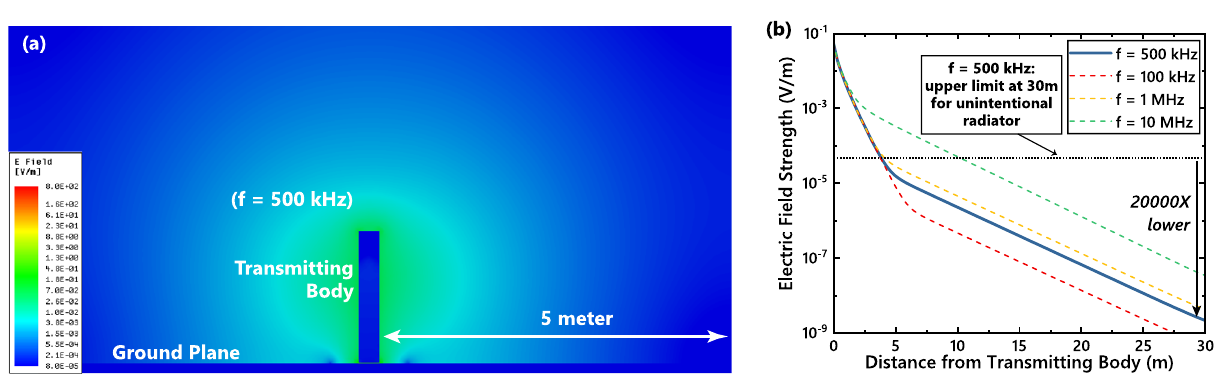
Figure 7. ( a ) Electric field decay from an EQS HBC device in a 2-D cross section at 500 kHz. ( b ) Plot of E-field decay vs distance shows that the E-Field drops 20000x below the FCC threshold to qualify as an unintentional radiator. This seconds the weak capacitive coupling demonstrated in Fig.